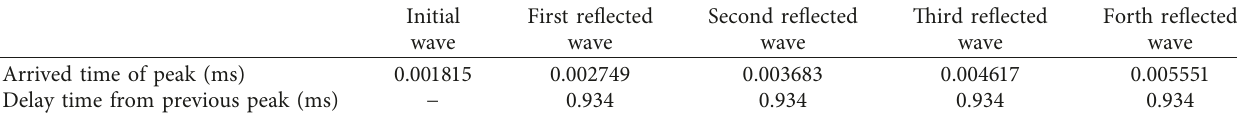
Table 4: The delay time between the peaks of initial wave and reflected